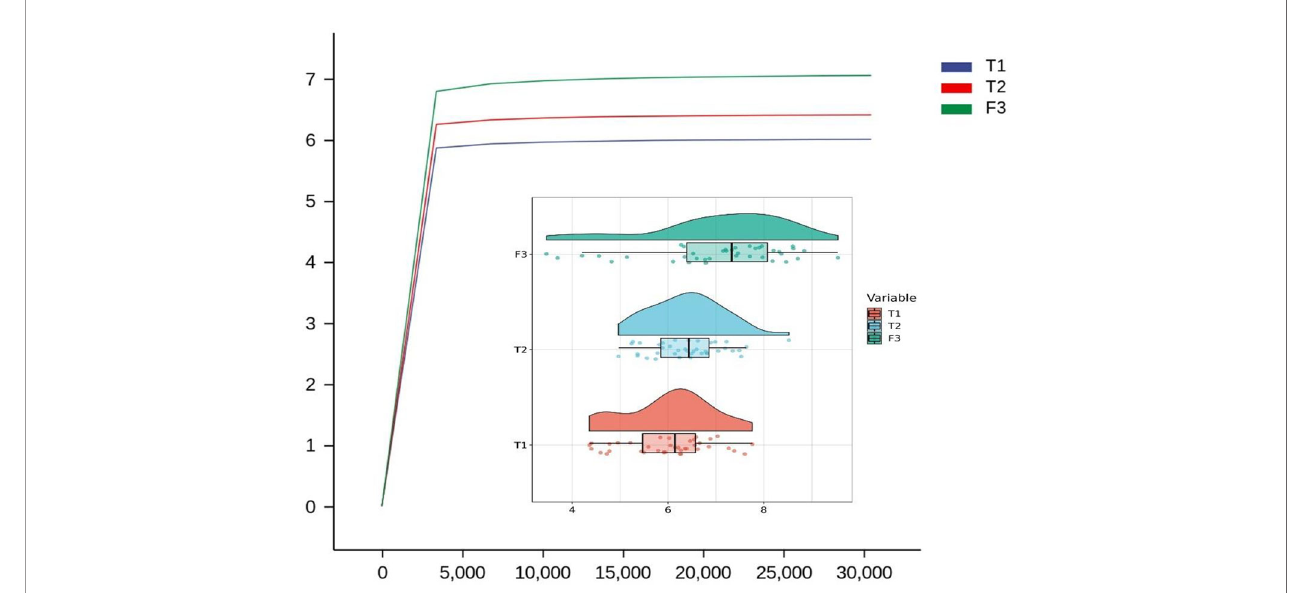
FIGURE 6 | The Rarefaction Curve and Raincloud Plot of tongue coating and intestinal microbiota and the difference of Shannon index (T1 is the tongue coating microbiota before sleep, T2 is the tongue coating microbiota after waking up, and F3 is the intestinal